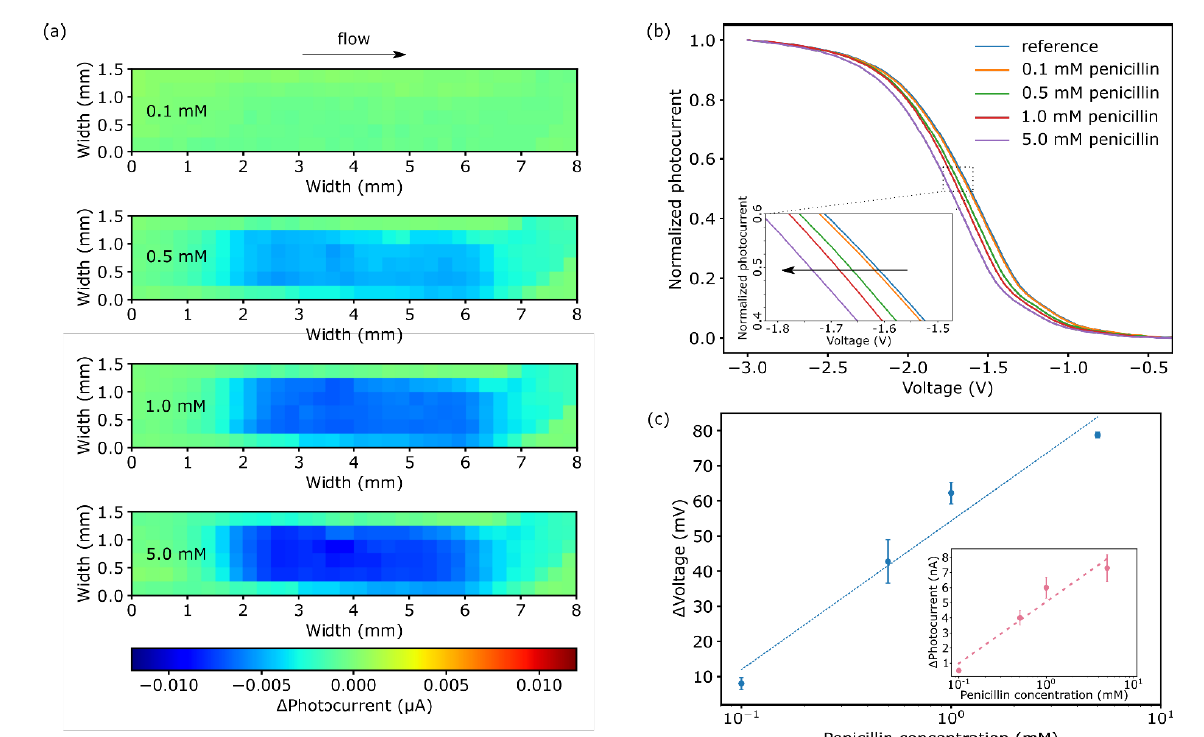
Figure 3. ( a ) Chemical images and ( b ) photocurrent-voltage curves for penicillin concentrations ranging from 0.1 to 5.0 mM after 5 min of enzymatic reaction in phosphate buffered saline (PBS) buffer, pH 7.0. ( c ) Mean calibration curve evaluated from the photocurrent-voltage curves ( n = 4) with an average penicillin sensitivity of 42.3 mV/dec. The inlet represents the photocurrent change in dependence of the penicillin concentration, evaluated from Figure 3a.